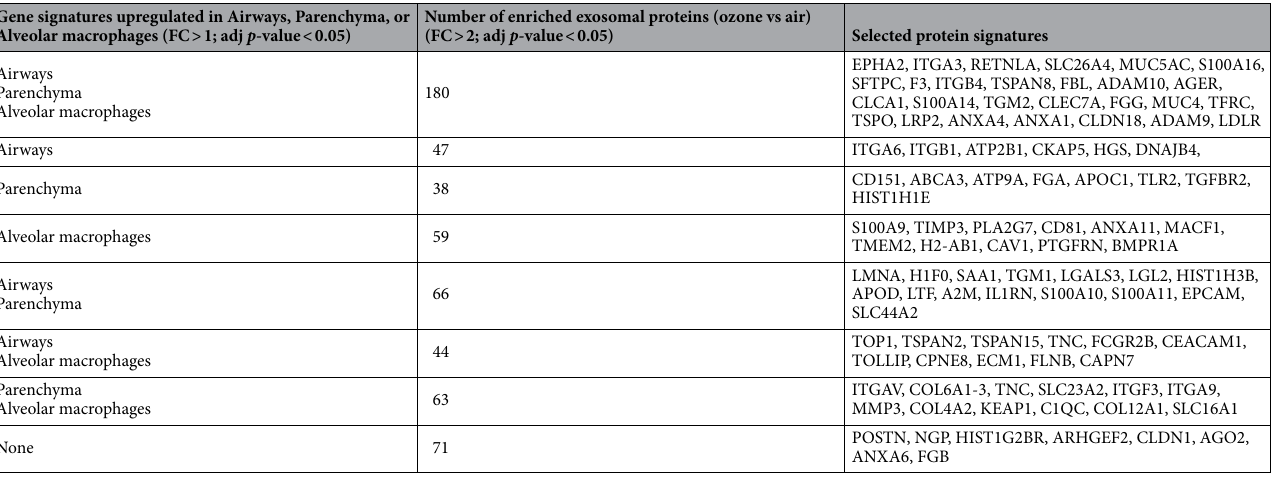
Table 5. Comparative analyses of enriched protein signatures from ozone-exposed mice and transcriptome from three lung compartments. 568 protein signatures that were found enriched in ozone-exposed mice versus air-exposed mice were interrogated for their respective gene signature upregulation in three different tissues, i.e., airway, parenchyma, and alveolar